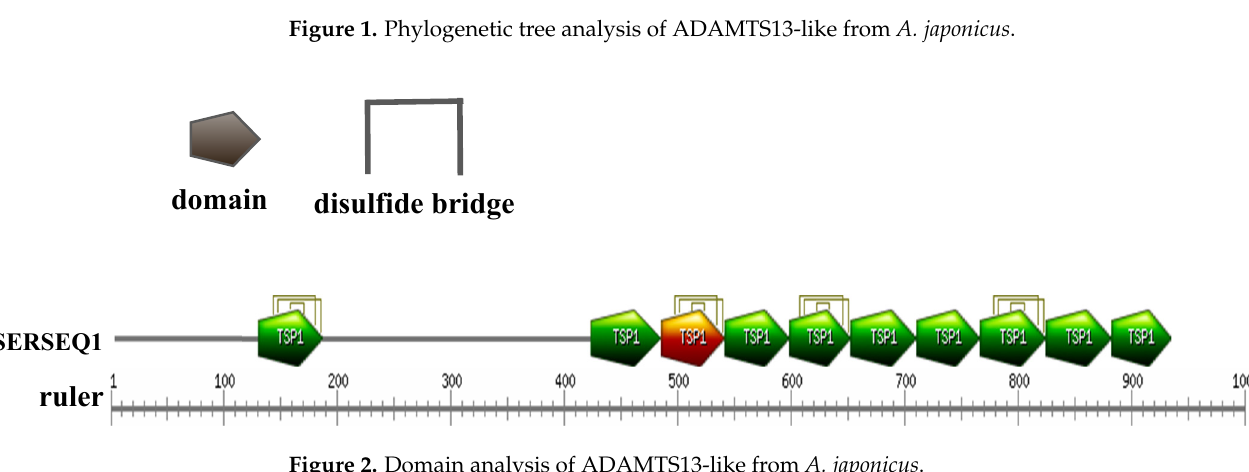
Figure 2. Domain analysis of ADAMTS13-like from A. japonicus .